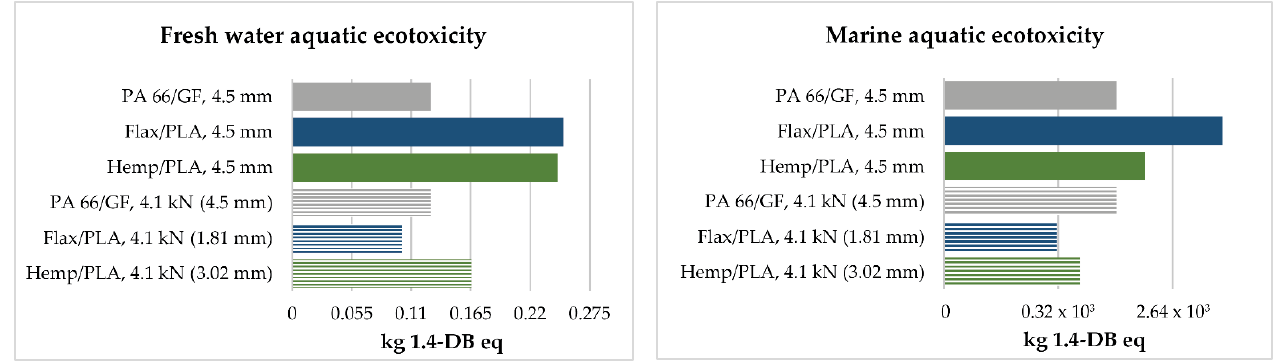
Figure 7. Environmental impact of hemp/PLA HN90, flax/PLA FN40, and PA 66/GF composites with both functional units. Method: CML-IA baseline V3.04/EU25/Characterization/Excluding long-term emissions.